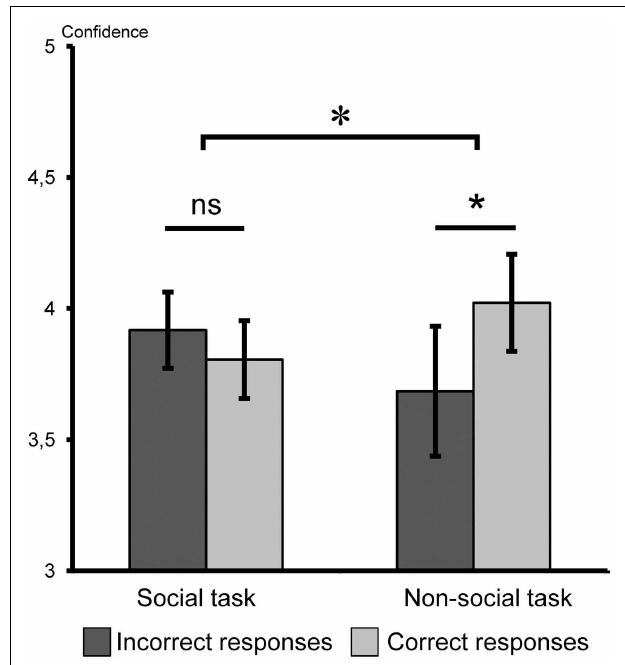
FIGURE 3 | Experiment 1, mean confidence ratings for correct and incorrect responses in the post-association phase for social and non-social categorization tasks. In light gray, correct responses; in dark gray, incorrect responses; * p < 0.05; ns, non-significant. Error bars indicate standard error of the